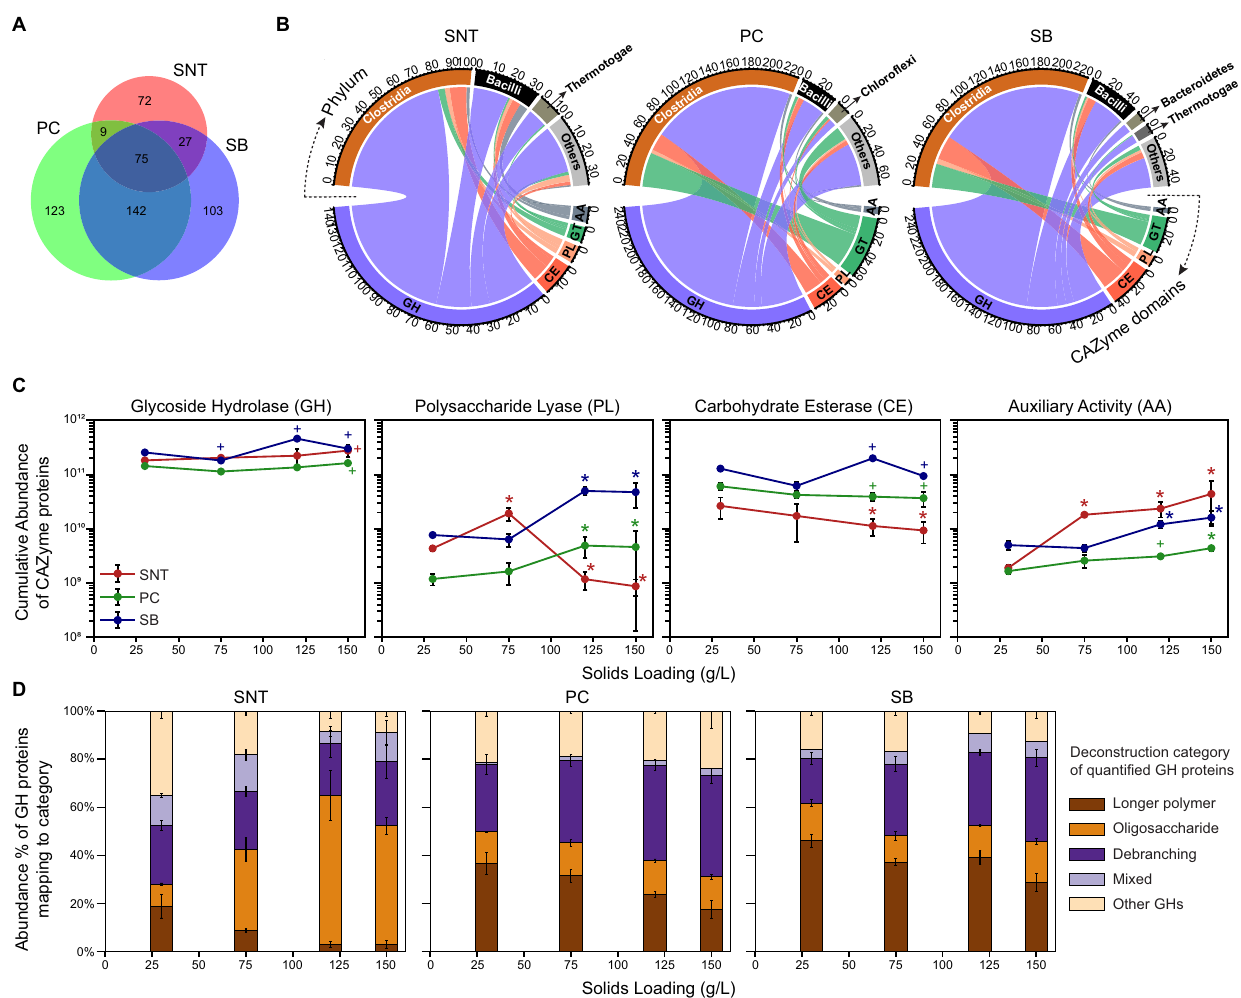
Fig. 2 Overview of the measured CAZymes ’ repertoire in the three fractions. A Venn diagram showing the overlap of CAZymes quanti fi ed in the three fractions. B For each fraction, the distribution of quanti fi ed CAZymes across the CAZyme classes (GH, CE, PL, GT, AA) with linkages showing the contributing taxonomic phyla (top half). Phyla producing <10 CAZymes were grouped as ‘ Others ’ . C Aggregate abundance trend of CAZymes from different CAZyme classes with increasing solids loadings per fraction. A two-tailed Welch ’ s t -test was performed with Benjamini Hochberg FDR correction from each solids loading versus the 30 g/L loading. + means adjusted (adj.) p -value ≤ 0.05 and * means adj. p -value ≤ 0.05 with absolute fold change ≥ 2× vs. respective 30 g/L condition. Exact p- values for each comparison are listed in Supplementary Data 6. D The relative distribution of each deconstruction sub-category within GHs. Data are presented as mean values ± SD ( n = 4 for 30 and 120 g/L, n = 3 for 75 g/L, and n = 5 for 150 g/L). SNT supernatant, PC planktonic cells, SB substrate bound, GH glycoside hydrolase, CE carbohydrate esterase, PL polysaccharide lyase, GT glycosyl transferase, AA auxiliary activity. Source data are provided as a Source Data fi